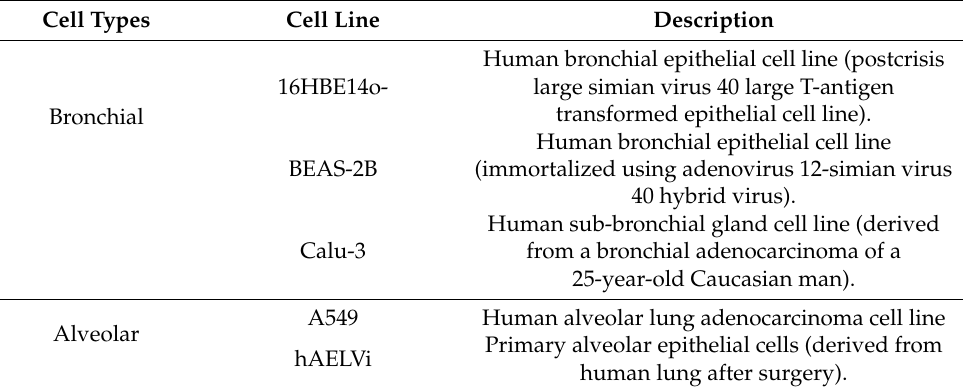
Table 1. Examples of cell culture models used to simulate epithelial barriers of the respiratory tract